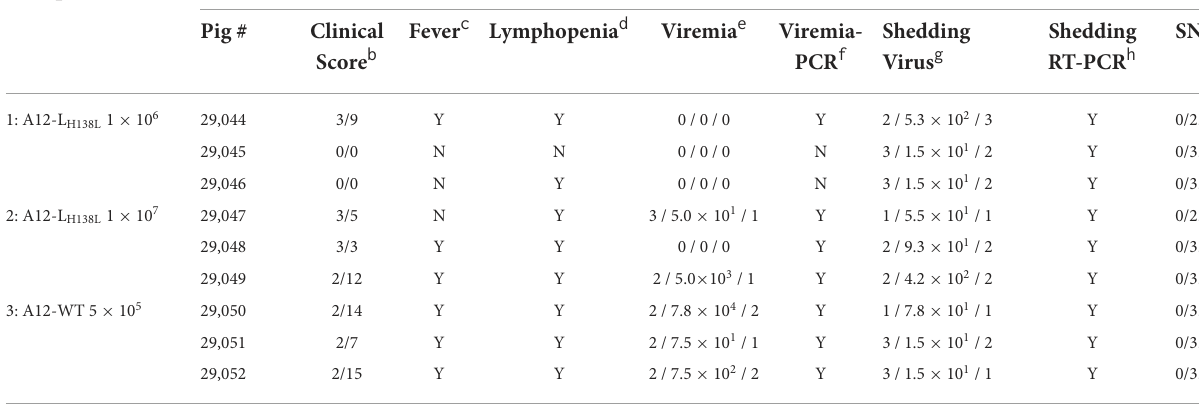
TABLE 1 Clinical performance of swine inoculated with varying doses of FMDV A12-L H138L or A12-WT. Group# and Dose a Clinical results after mutant or WT virus inoculation in swine Pig